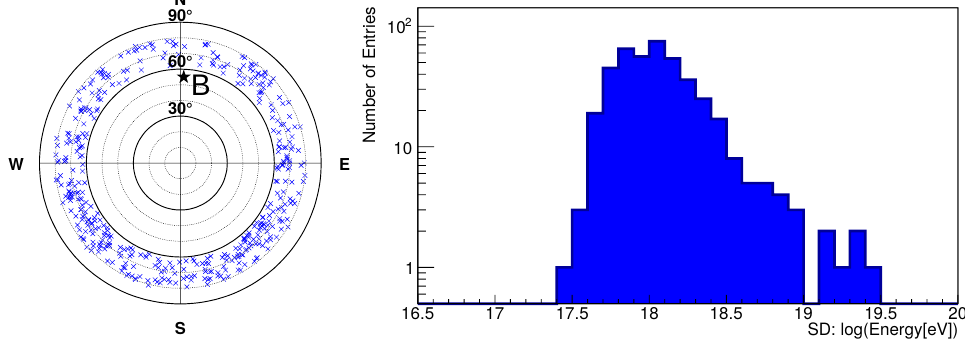
Figure 3. The data sample and data selection of the externally triggered AERA events in the period from 1st of January 2012 to 15th of August 2015 results in 427 high quality events.